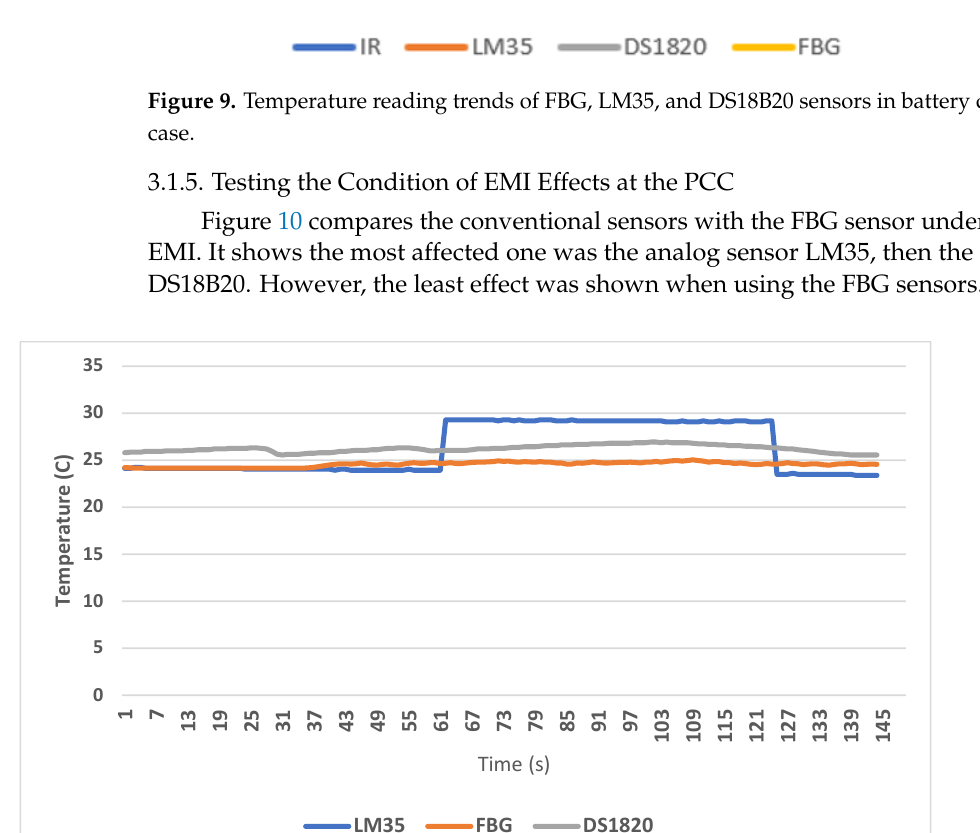
Figure 11. HV effects on the FBG, LM35, and DS18B20 sensors.